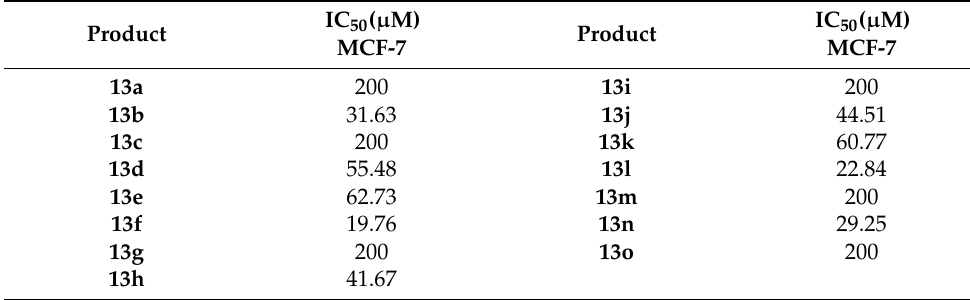
Table 2. IC 50 of the compounds 13a to 13o in MCF-7